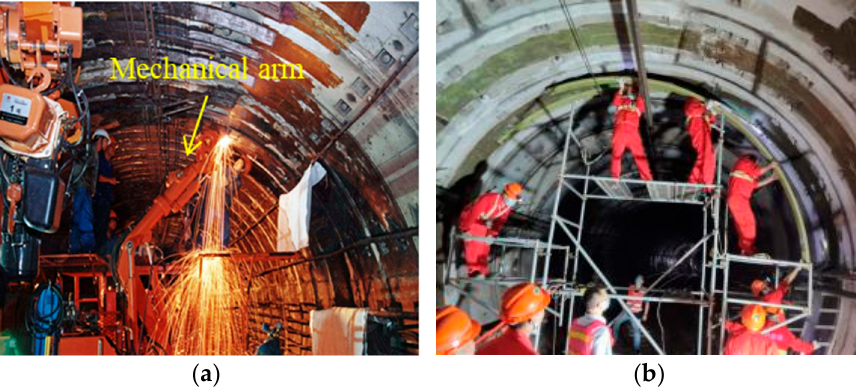
Figure 1. The installation construction in the shield tunnel: ( a ) steel plate; ( b ) filament wound pro- files. Table 1. The comparison of single parts’ self-weight between steel plate reinforcement and FWP reinforcement.